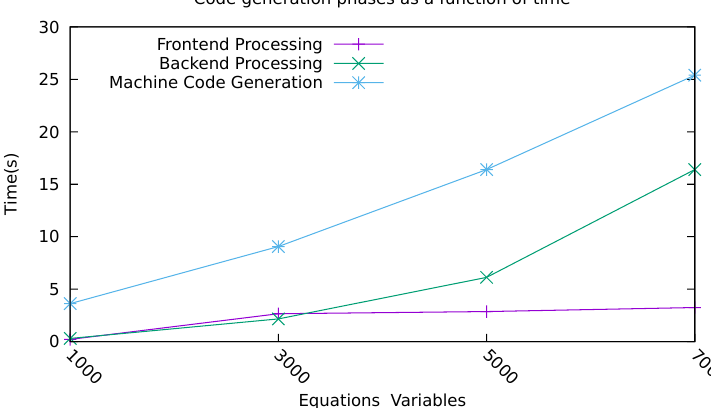
Figure 12. Median time spent in seconds in frontend, backend and code generation phases when simulating the model in Listing